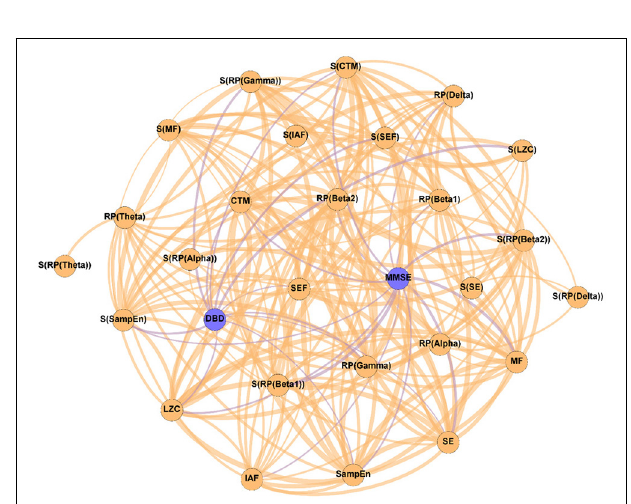
FIGURE 3 | Parameter network of the patients with AD after the NPT (Post-NPT network). Wider edges correspond with stronger associations. Nodes corresponding to cognitive and behavioral parameters are shown in blue, while nodes of neurophysiological parameters are shown in